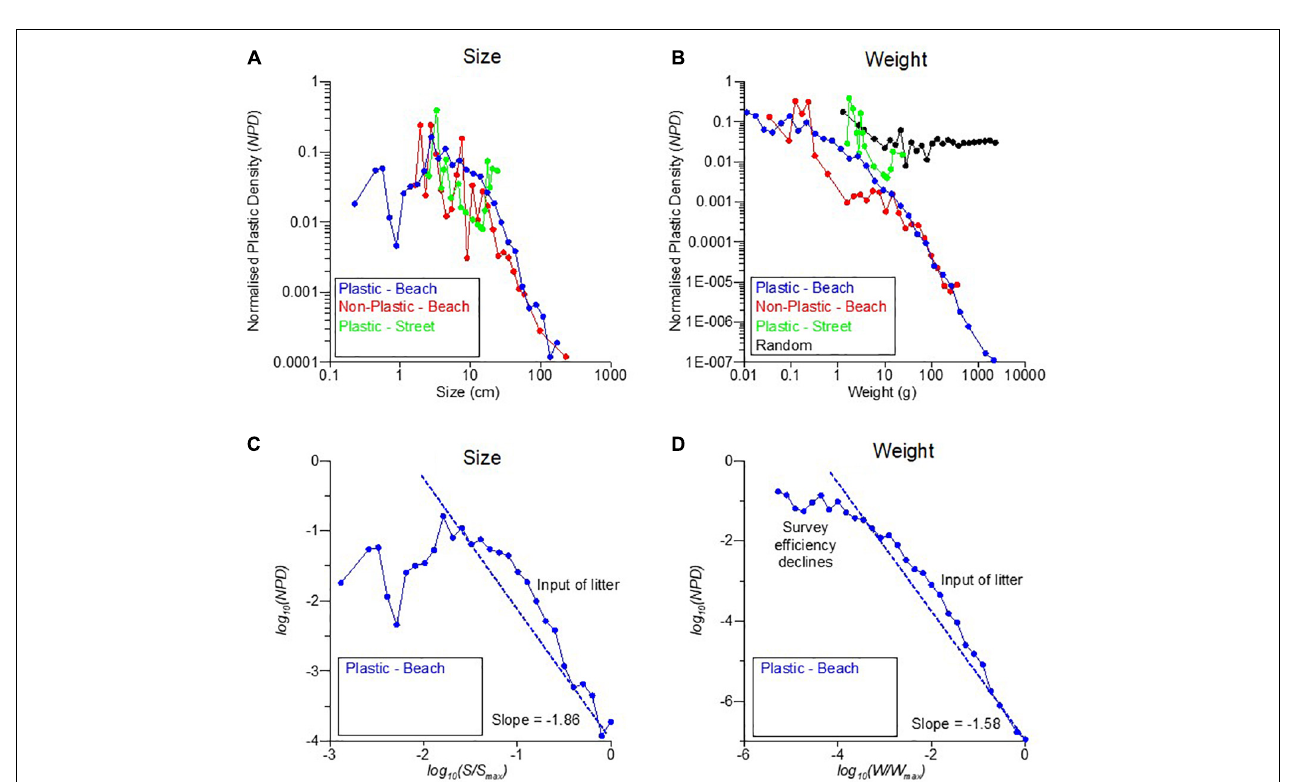
FIGURE 6 | Size and weight characteristics of Scottish North Sea beach litter. Data sets are: Blue symbols–Beach Plastic Litter: 1,426 plastic beach litter items collected during 80 surveys of northeast of Scotland beaches, 2019–2020. Red symbols–Beach Non-Plastic Litter: 190 non-plastic beach litter items from the 80 surveys. Black symbols–Random Weights: 1,400 model particles randomly distributed in weight between 0.01 and 2,600 g. Green symbols–Street Plastic Litter: 67 plastic street litter items collected from 10 surveys in coastal towns in the northeast of Scotland, 2020. Thirty size and weight intervals (i.e., n = 30) were used for each data set, with the boundaries of each interval calculated as described in the “Methods” section. x -axis: Sizes and weights are the centroids of size and weight intervals. Normalized Plastic Density ( NPD ) calculated for (A) sizes and (B) weights. Interpretation of beach plastic litter results for (C) sizes and (D) weights.